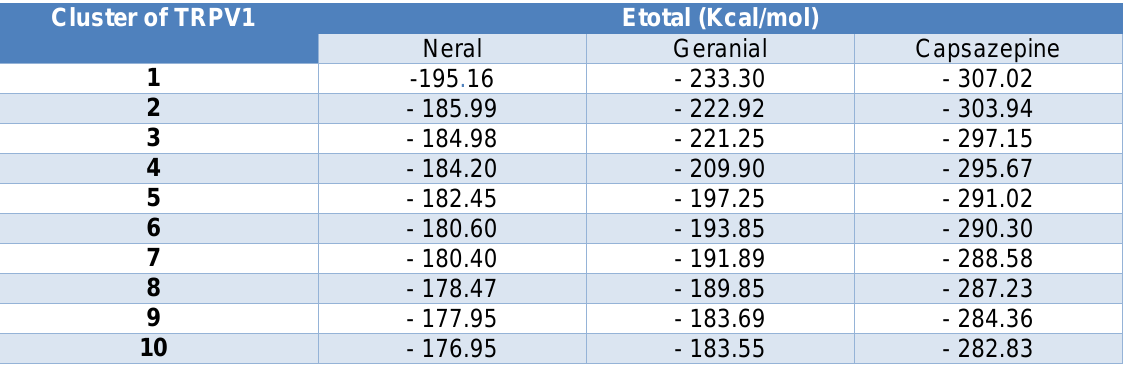
Figure 7: Geranial (upper left panel) showing high specificity for the structural center of the channel, marked in red, since all 10 most energetic clusters overlap in the same place. This is not the case with the neral (upper right panel) isomer, overlapping only 3 of the 10 most energetic clusters. Steric impediment caused by the most energetic geranial cluster (yellow); steric impediment caused by the neral (pink). In addition to providing greater blockage of the center of the channel, the geranial (yellow) also makes chemical bonds with amino acid residues from the 4 subunits, which does not happen with the neral, it provides greater stability to the geranial. Table 3: Binding energies between citral isomers and capsazepine against TRPV1 channel (E total –